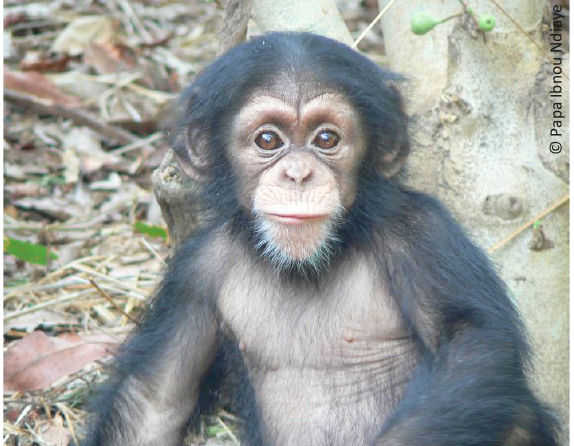
AfricaSenegal Study